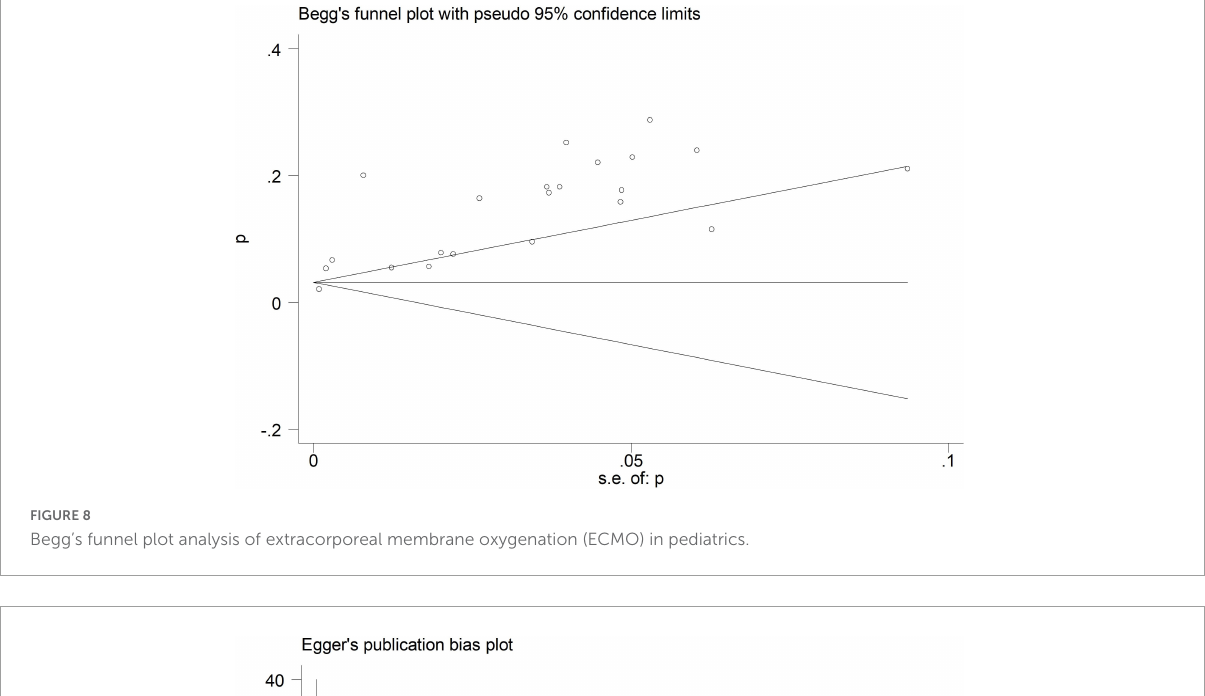
FIGURE8 Begg’s funnel plot analysis of extracorporeal membrane oxygenation (ECMO) in pediatrics.